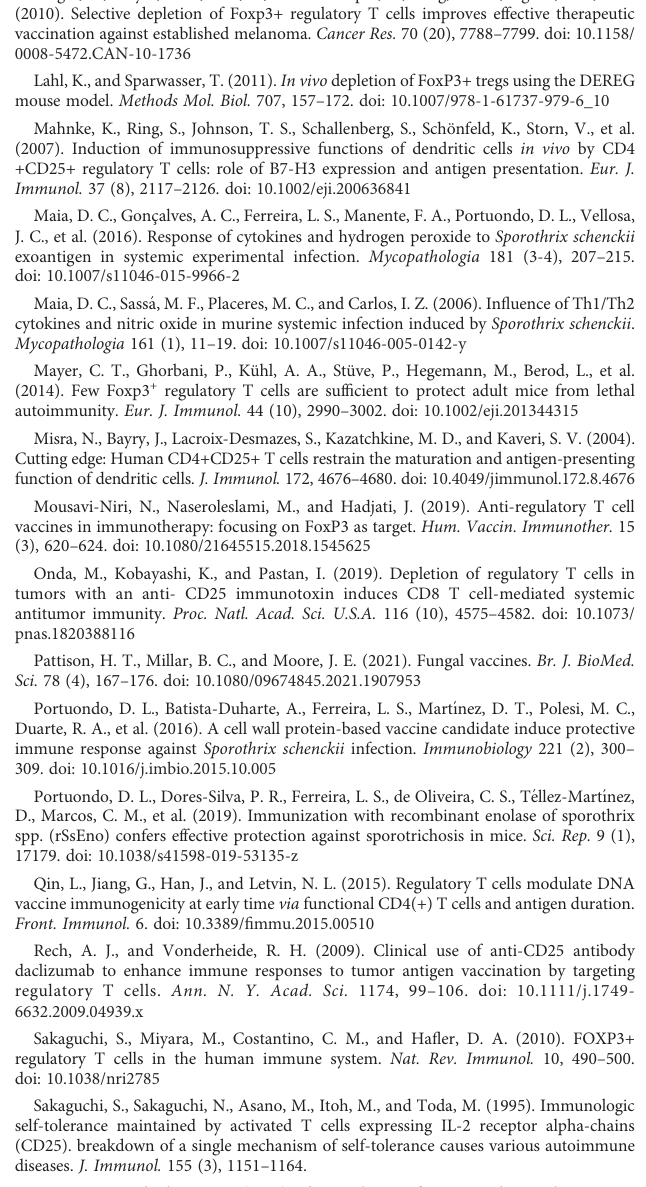
Main clinical fi ndings in the S. brasiliensis- infected mice at 35 days post infection. *In vaccinated mice the nodules in the liver were scarcely present,